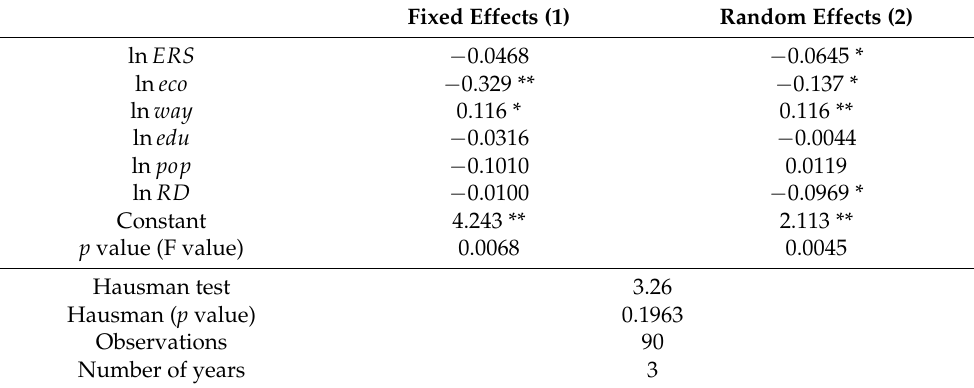
Table 6. Empirical